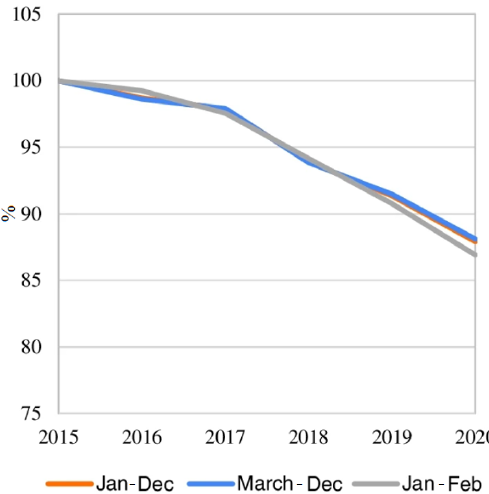
Figure 9. Development of wine consumption in Europe in recent years [59].